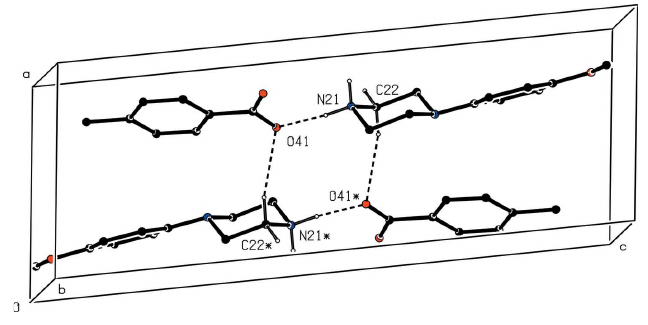
Figure 6 Part of the crystal structure of compound (I) showing the formation of an R 2 (10) ring linking adjacent [010] chains. Hydrogen bonds are drawn as 4 dashed lines and, for the sake of clarity, the H atoms bonded to those C atoms that are not involved in the motif shown have been omitted. The atoms marked with an asterisk (*) are at the symmetry position (1 (cid:3) x , (cid:3) y , 1 (cid:3) z